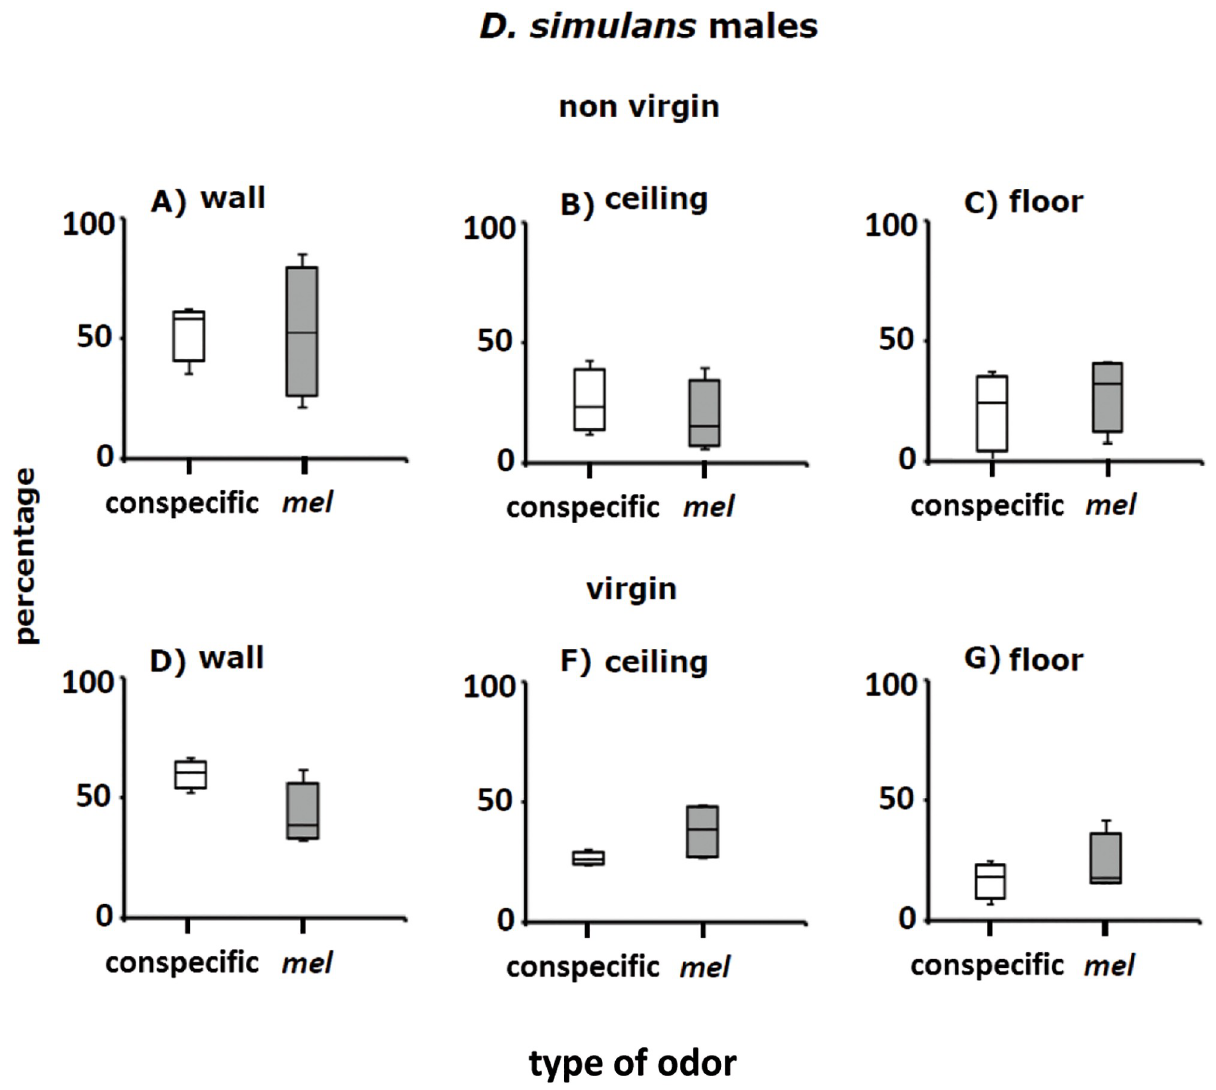
Fig 9. Perch preferences (percentages) of non-virgin and virgin males of D . simulans in Petri dishes with conspecific adult odorants (white columns) and adult odorants of D . melanogaster (grey columns). Conspecific alludes to Petri dishes with conspecific odors; mel stands for Petri dishes with adult D . melanogaster odors. See also Fig